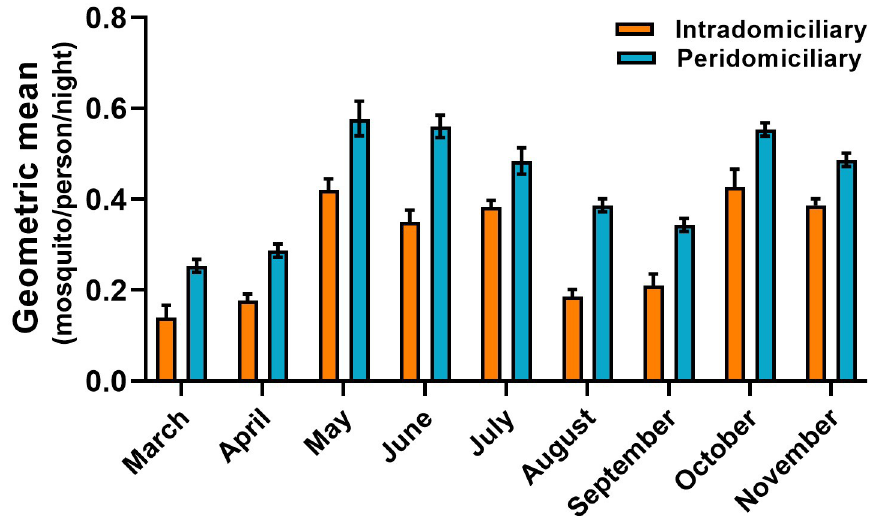
Fig 4. Behavior of the monthly density of Anopheles (Nys . ) darlingi in five communities of the Darien region, between March and November 2016 (geometric mean ± 95% confidence interval).